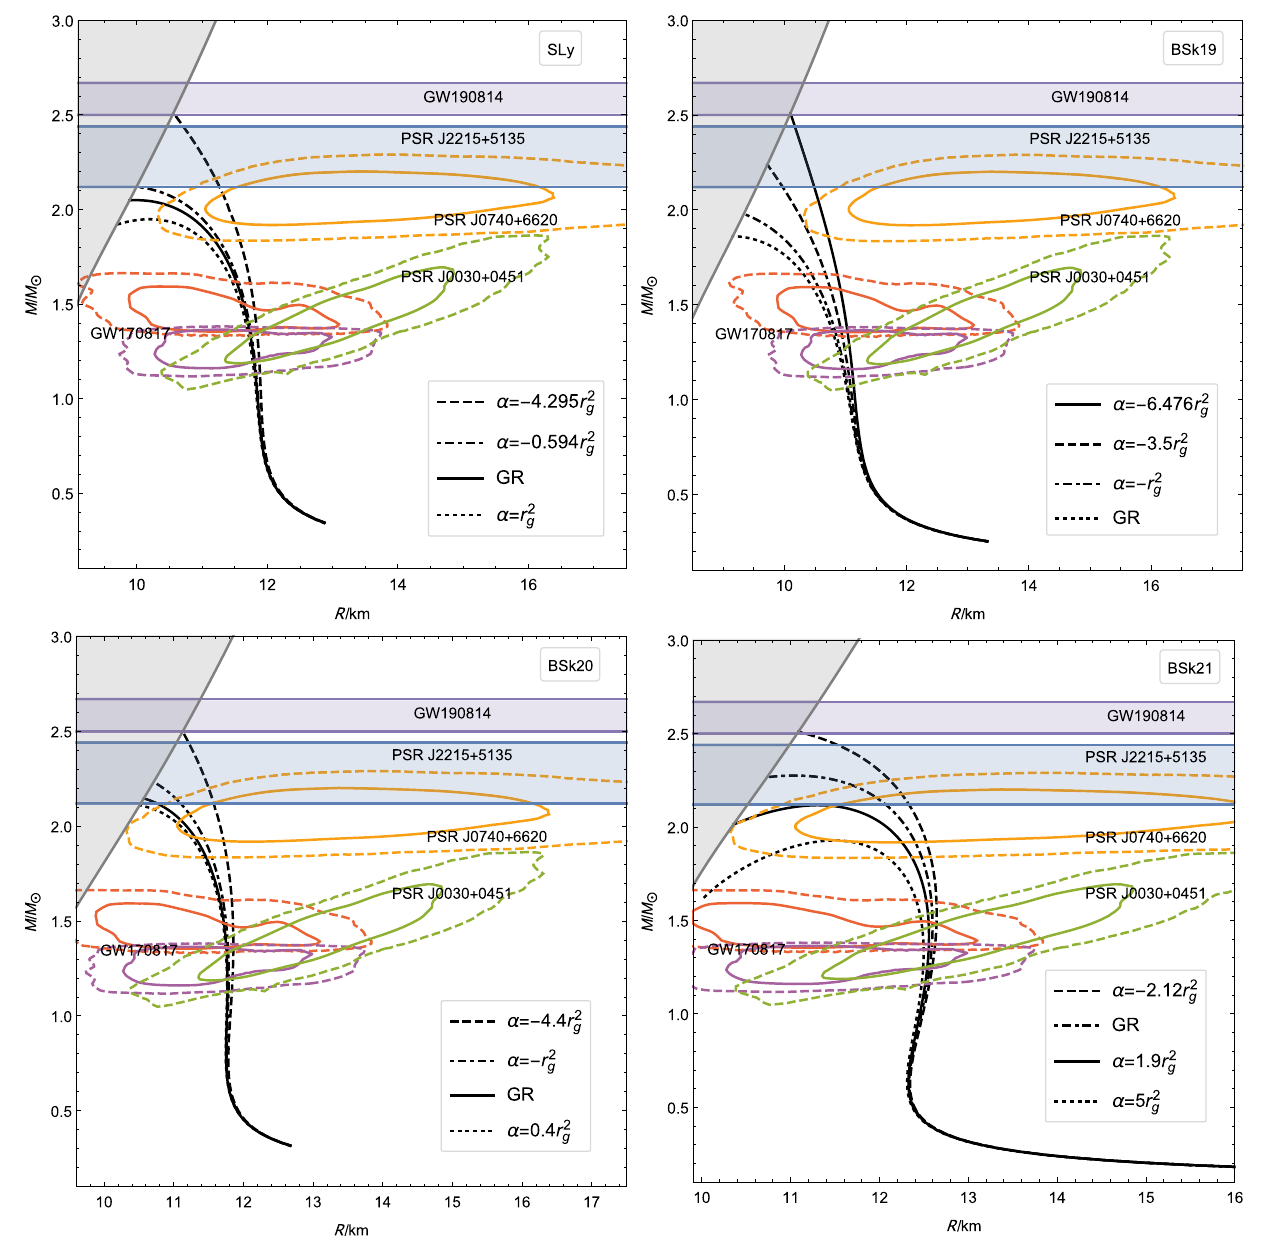
Fig. 7 Mass–radius curves for SLy, BSk19, BSk20, and BSk21 EOSs, compared with the observation